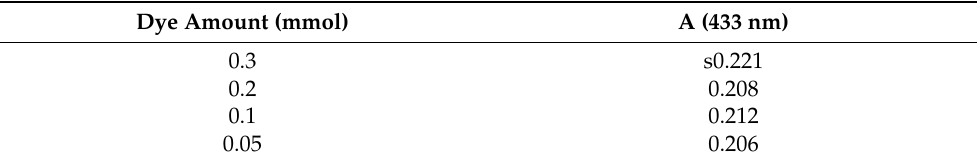
Table 3. Dye amounts tested for CMC functionalization and A value at 433 nm registered for 0.5% CR-CMC@ aqueous